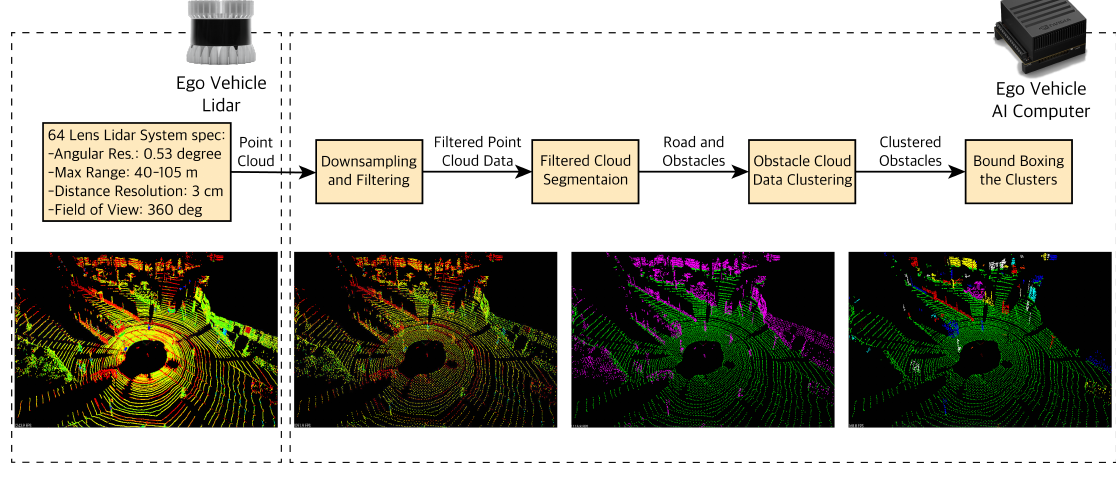
Figure 11. LiDAR data processing pipeline. Images from left to right: Dense LiDAR point cloud data, downsampled and filtered LiDAR data, segmented point cloud into road and obstacles, clustered obstacles in the segmented point cloud. The center dark spot is the ego